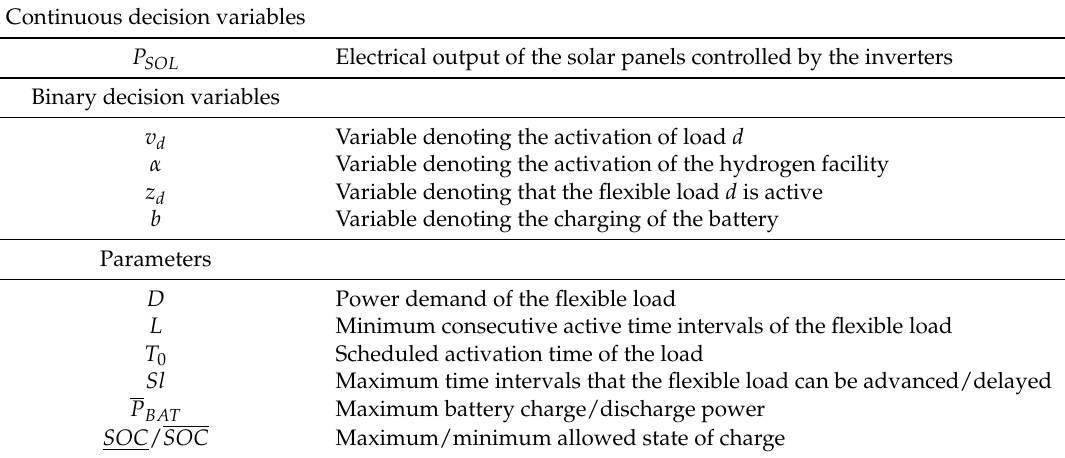
Table 2. Description of the model predictive control’s (MPC) decision variables and parameters. Continuous decision